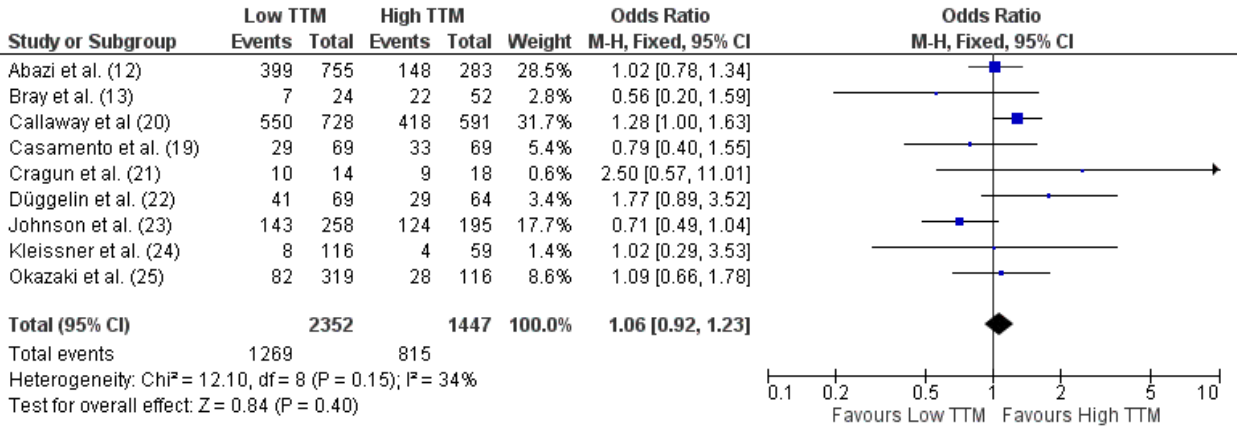
Figure 3. Forest plot for mortality in all patients with reported outcome. Low TTM = TTM at 33 °C; High TTM = TTM at 36 °C. The size of the squares for the risk ratio reflects the weight of the trial in the pooled analysis. The horizontal bars represent 95% confidence intervals (CIs).